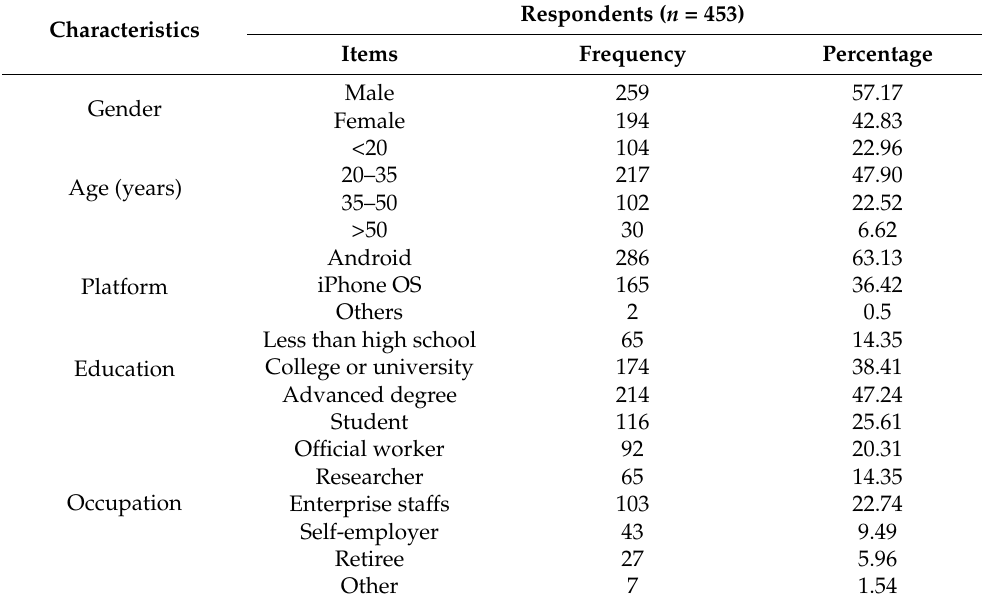
Table 1. Respondent personal information.